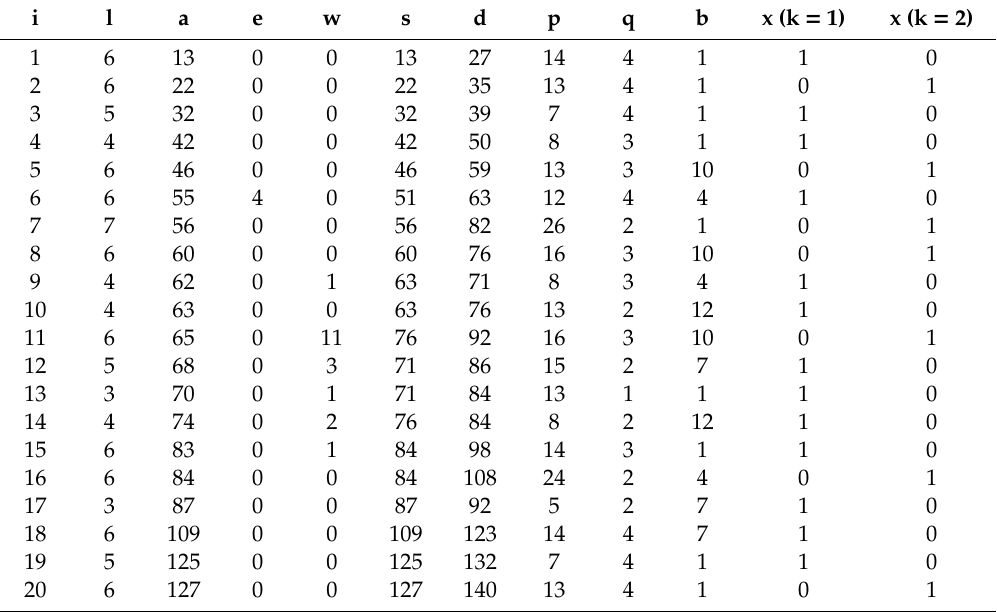
Table A4. Results of the integrated BAP and QCAP solution for Case 7: seed = 700, λ = 3.2, Z (cid:48) = 302.